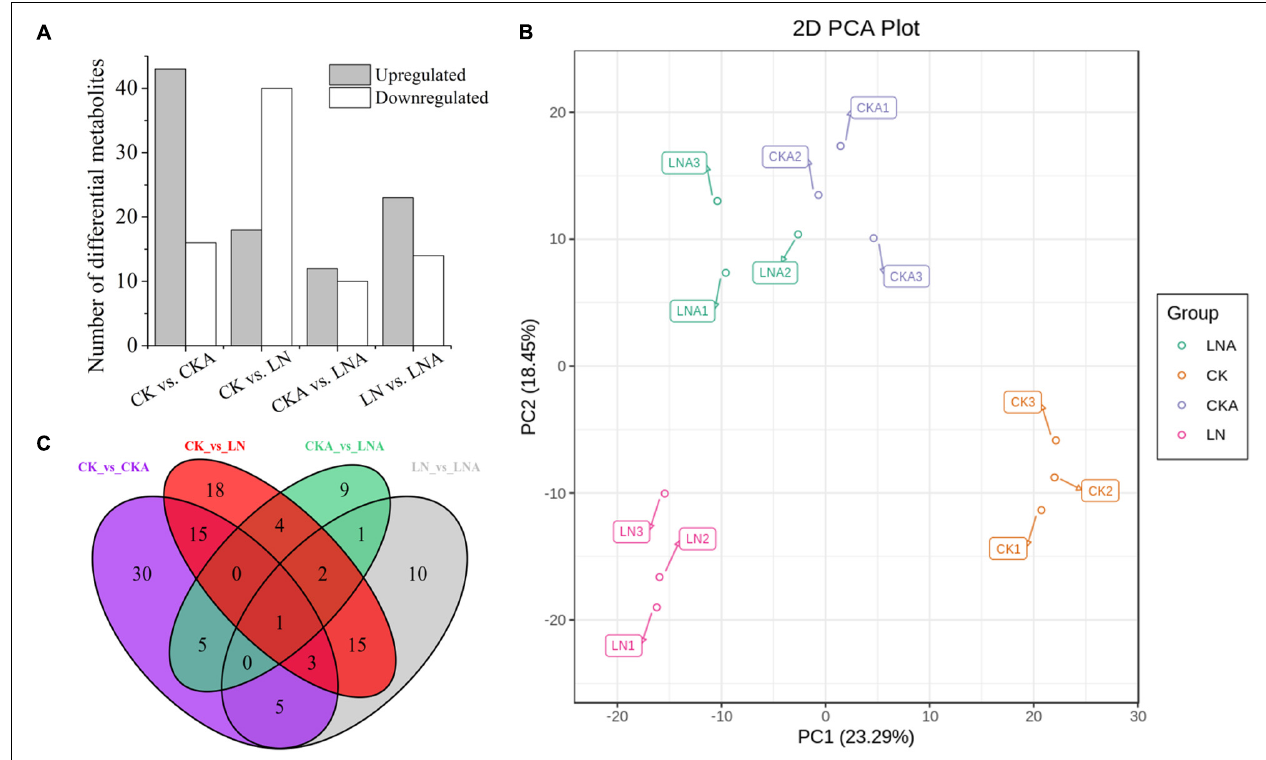
FIGURE 8 | Differential metabolite analysis. Number of differential metabolites for the comparisons CK vs. CKA, CK vs. LN, CKA vs. LNA, and LN vs. LNA (A) . PCA score diagram of each group. PC1 represents the first principal component, and PC2 represents the second principal component (B) . Venn diagram of the common metabolites and differential metabolites among the four groups (C) . Significantly regulated metabolites were those with fold change ≥ 2 or fold change ≤ 0.5 and VIP ≥